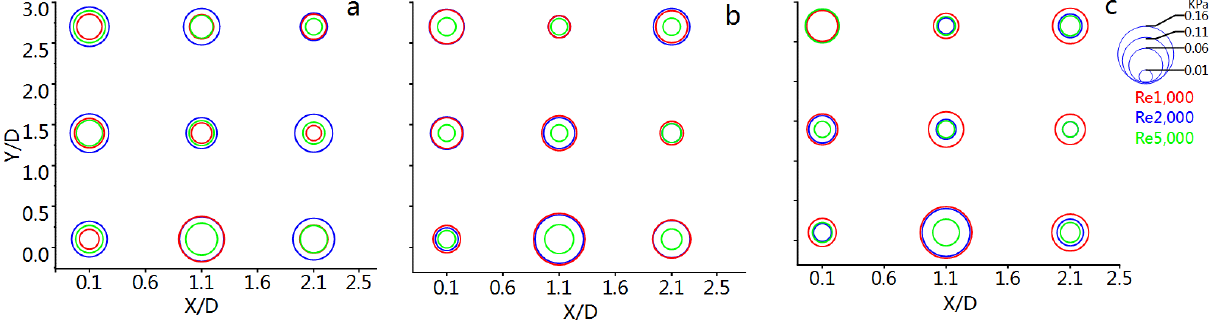
Figure 13. RMS of the fluctuating pressure: ( a ) Ar = 0.2; ( b ) Ar = 0.3; ( c ) Ar = 0.5.